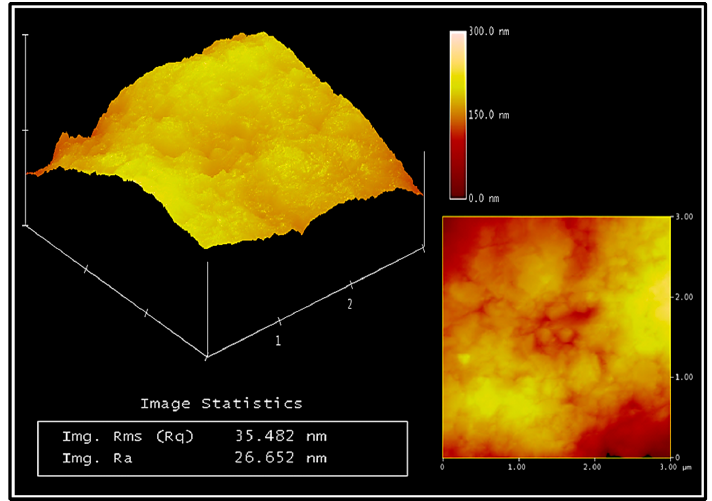
Figure 6. Atomic force microscope images of the dispersed graphene nanoplatelets monolayer on a glass substrate.